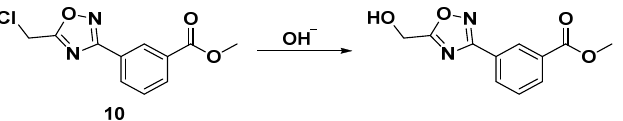
Table 1. Effects of reaction conditions on the synthesis of compound 5 .